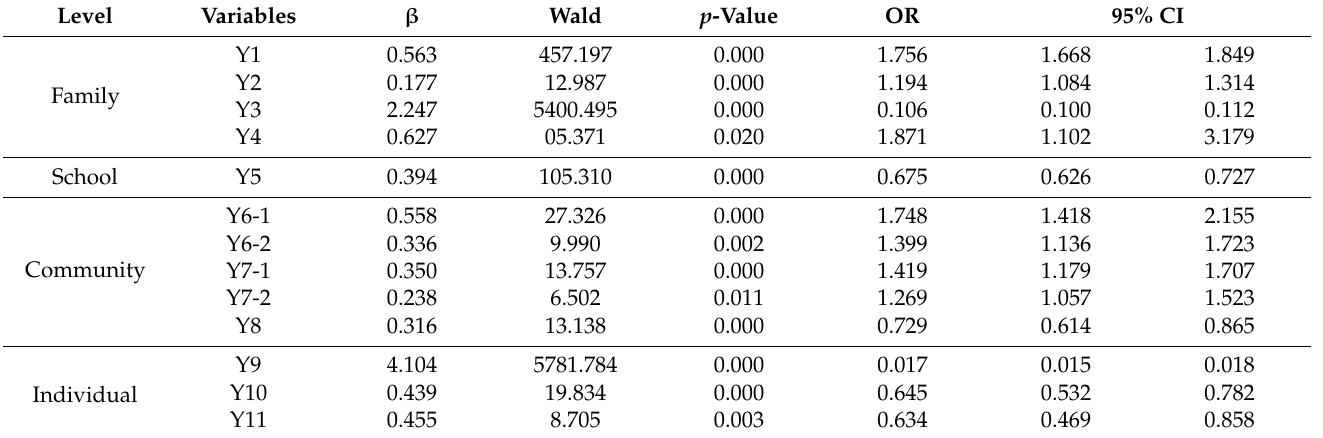
Table 6. Binary logistic regression analysis affecting the participation of children and adolescents aged 7–18 years in soccer sports